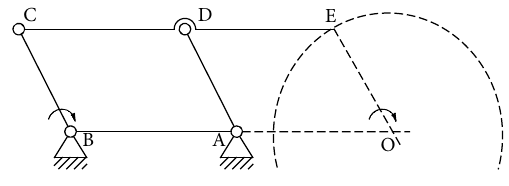
Figure 5: Parallel four-bar VRC